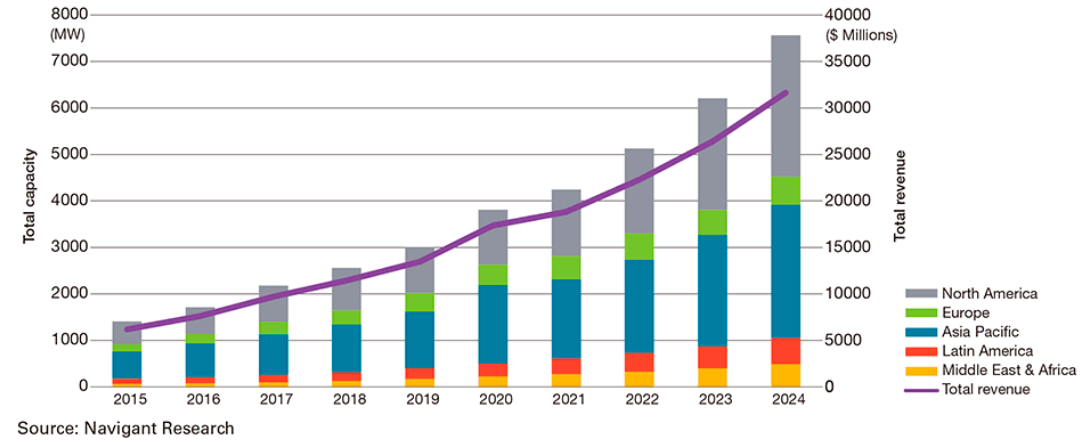
Figure 1. Microgrid installation and revenue generation.